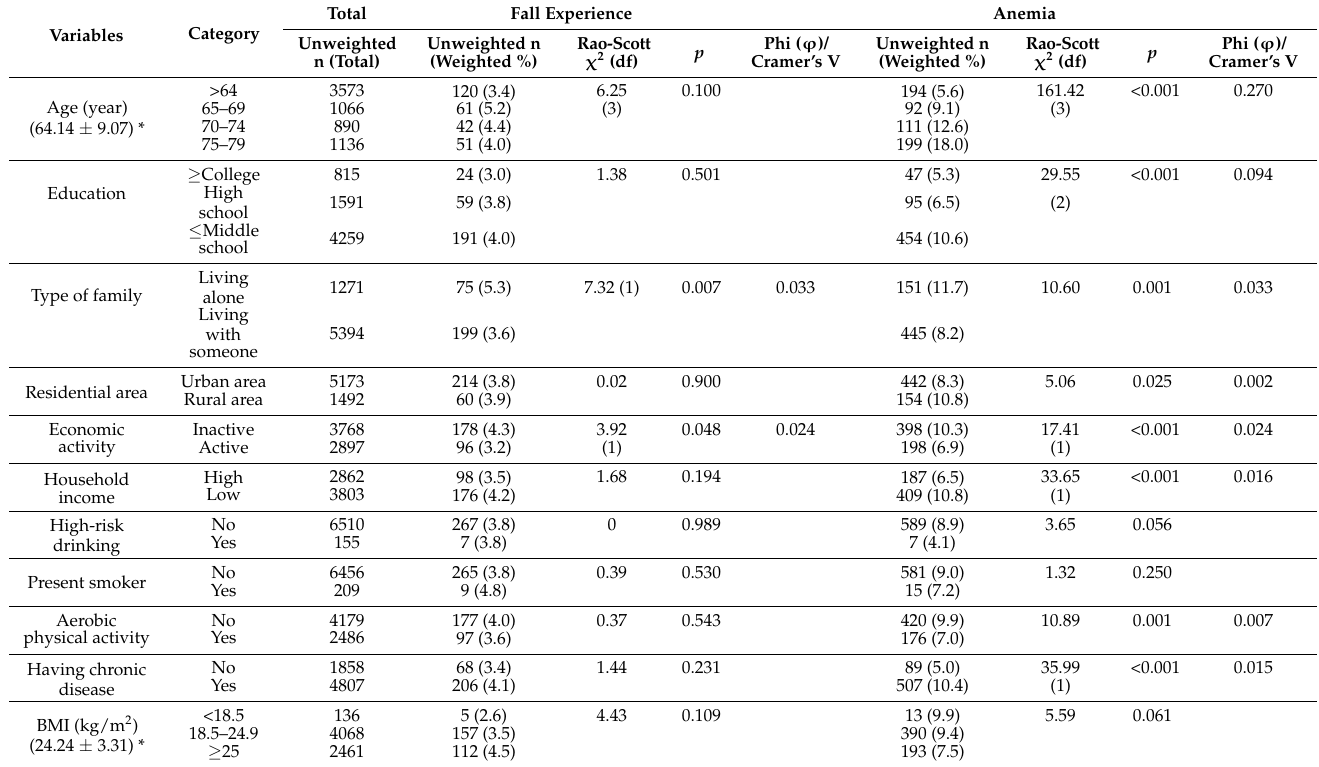
Table 1. Fall experience and anemia according to the subjects’